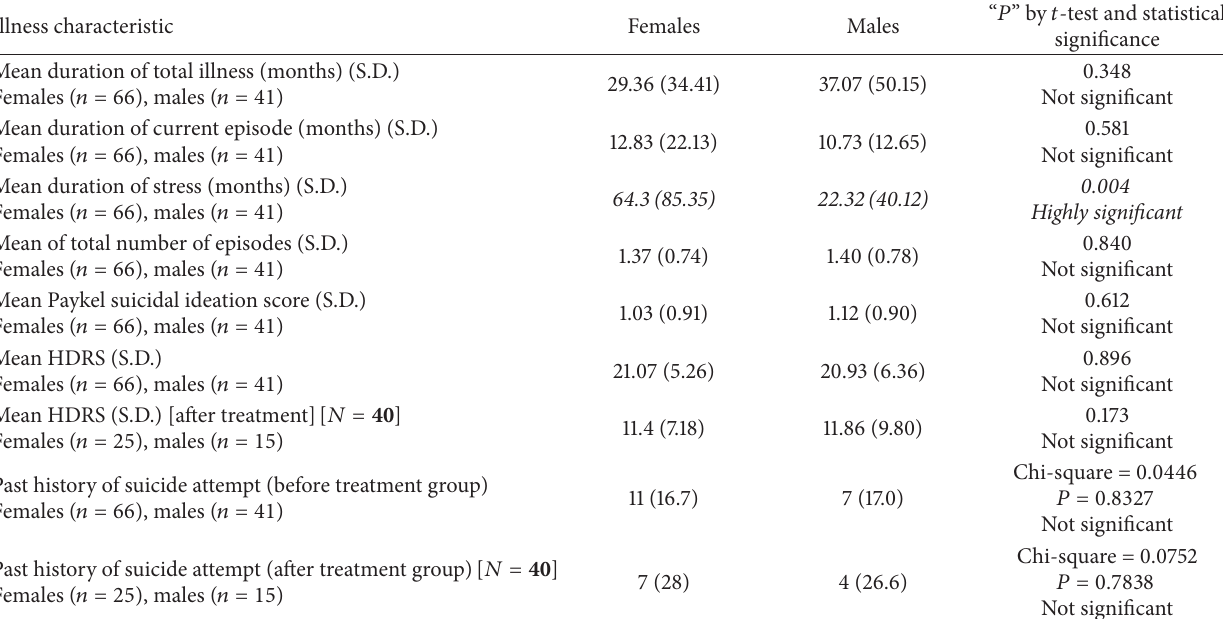
Table 2: Comparison of duration of stress and illness characteristics across gender. Illness